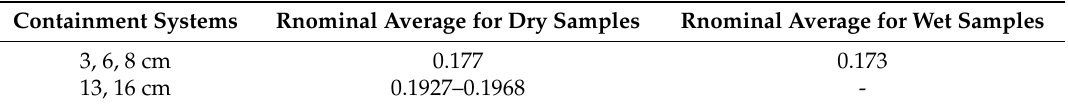
Table 2. Nominal thermal resistance (Rnominal).